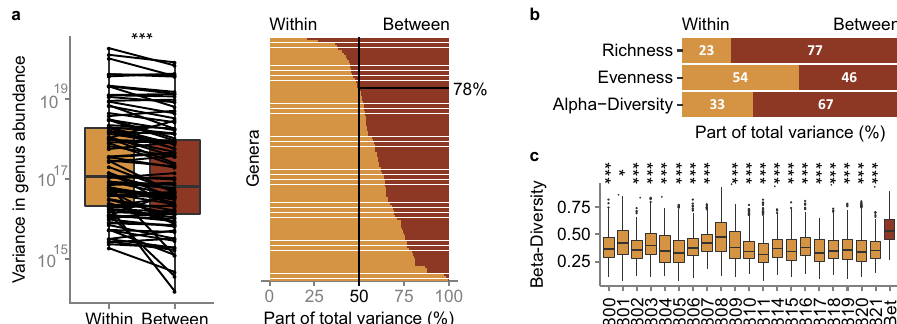
Fig. 1 Extensive within- compared to between-subject variance in genus abundances are re fl ected partly in alpha-diversity but not in beta-diversity measures. a Within- versus between-subject variance in absolute genus abundance (Wilcoxon test, two-sided, n = 96, P = 1.75 × 10 − 7 ) (left) and within- subject and between-subject variance as part of the total variance in genus abundance (right) for all genera over the abundance threshold. b Within- and between-subject variance as part of the total variance in alpha diversity measures, for observed richness, Pielou evenness, and Shannon diversity index based on QMPs. c Beta-diversity, as assessed through Bray Curtis dissimilarity, between samples of the same individual (800 – 821), and between the fi rst sample of each individual (Bet) based on QMPs. Signi fi cance of the differences within and between individuals were tested through an ANOVA on multivariate homogeneity of group dispersions ( N = 20, n = 694). The body of the box plots represents the fi rst and third quartiles of the distribution, and the median line. Whiskers extend from the quartiles to the last data point within 1.5×IQR, with outliers beyond. Signi fi cance levels: ***: 0.001, **: 0.01, *: 0.05. The same fi gure based on RMPs can be found in Supplementary Fig.